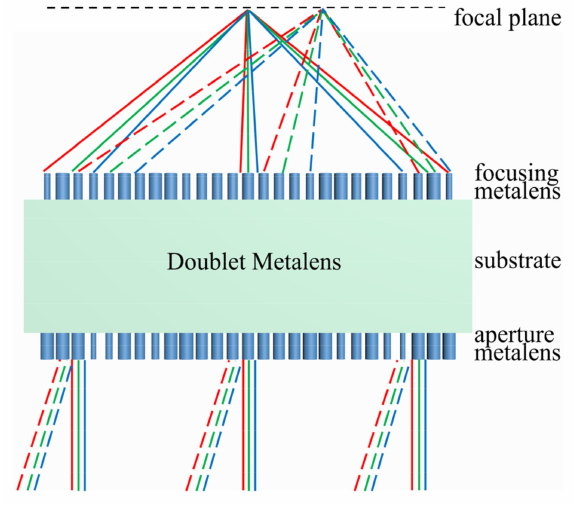
Figure 1. Schematic of the doublet metalens, which simultaneously achieves chromatic and off-axis monochromatic